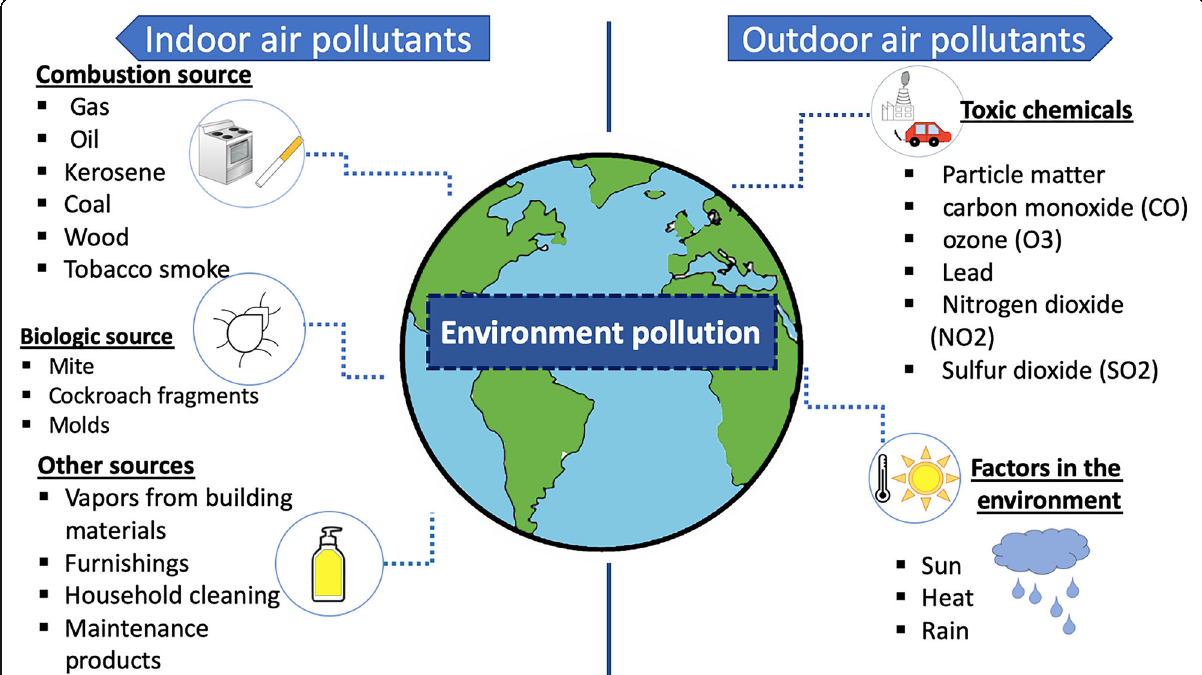
Fig. 1 Relationships between air pollutants and environmental